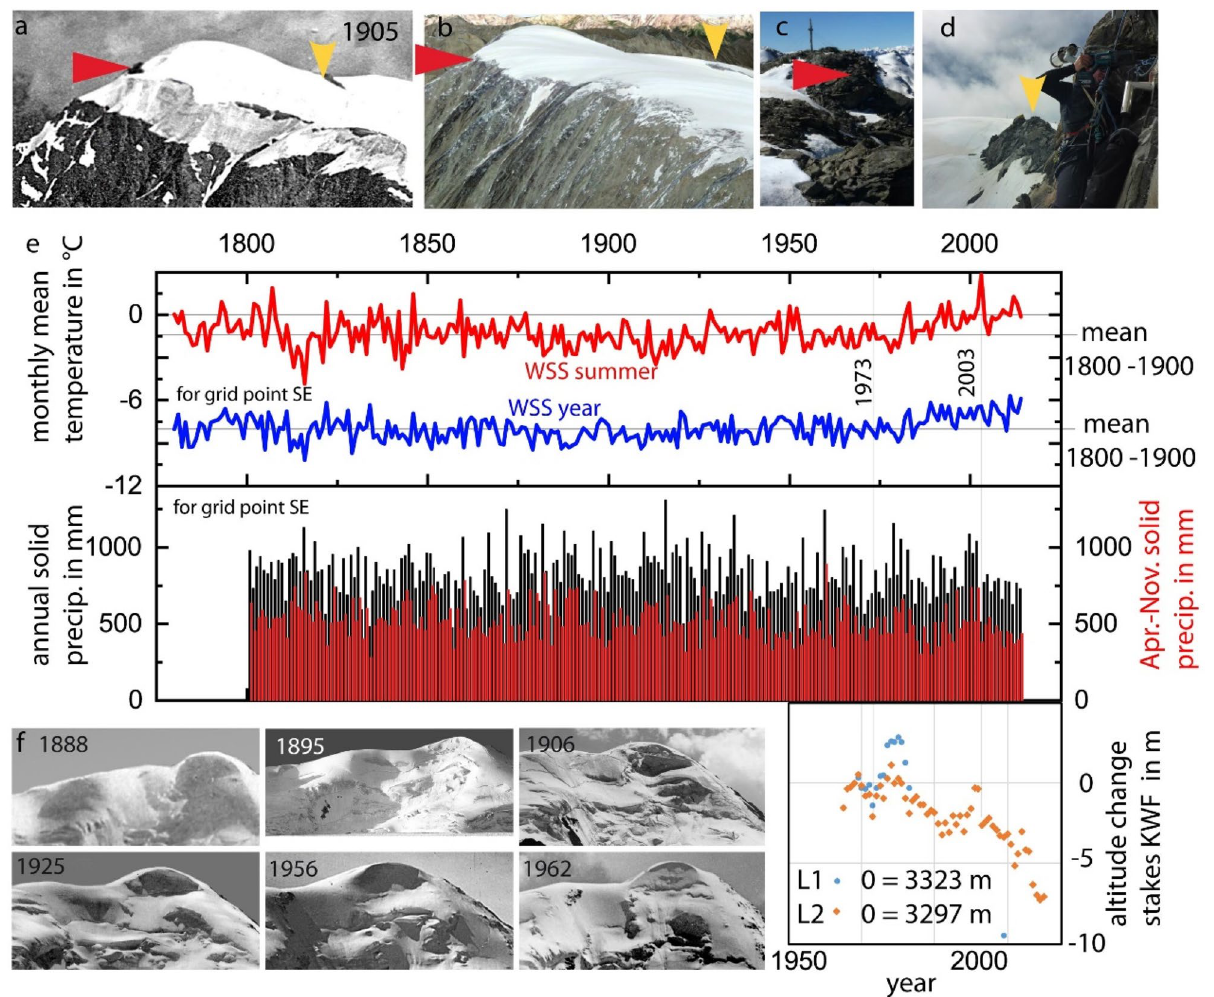
Figure 4. The comparison of the ( a ) historical photograph from 1905 with ( b ) one of 12.08.2021 supports the maximum elevation change of 34.9 ± 10.0 m between 1893 and 2018 and shows that the ( c,d ) rock ridges marked by arrows in ( a–d ) were ice-free during the late LIA. ( e ) Mean annual and summer temperatures for the HISTALP grid point SE extrapolated to Weißseespitze show an increase starting in the 1980s. Solid precipitation for the total year (black bars) and April–November (red bars) both decrease in the twenty-first century. The thickness at stakes L1 and L2 at Kesselwandferner increased with solid precipitation peaks in the 1980s and late 1990s, and decreased with melt events, e.g. in 1973 and most remarkably since 2003. The time series of historical photographs ( f ) of Weißseespitze summit shows varying steepness of the ice cliff, but an unchanged dome shape. Data Source: HISTALP temperature and precipitation data 40 , federal administration of Tyrol data.tirol.gv.at, photo by Andrea Fischer 27,34–37